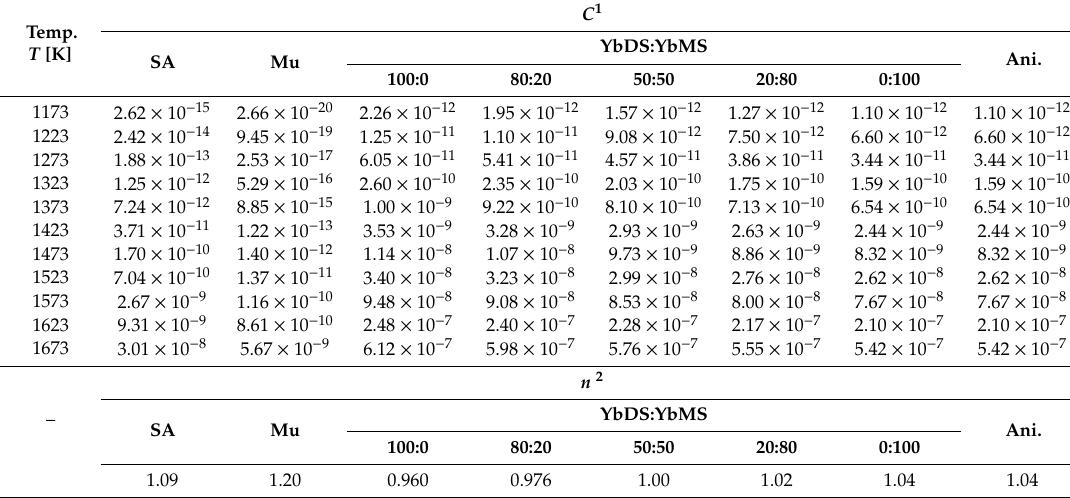
Table 8. Creep properties ( C and n ) of coating